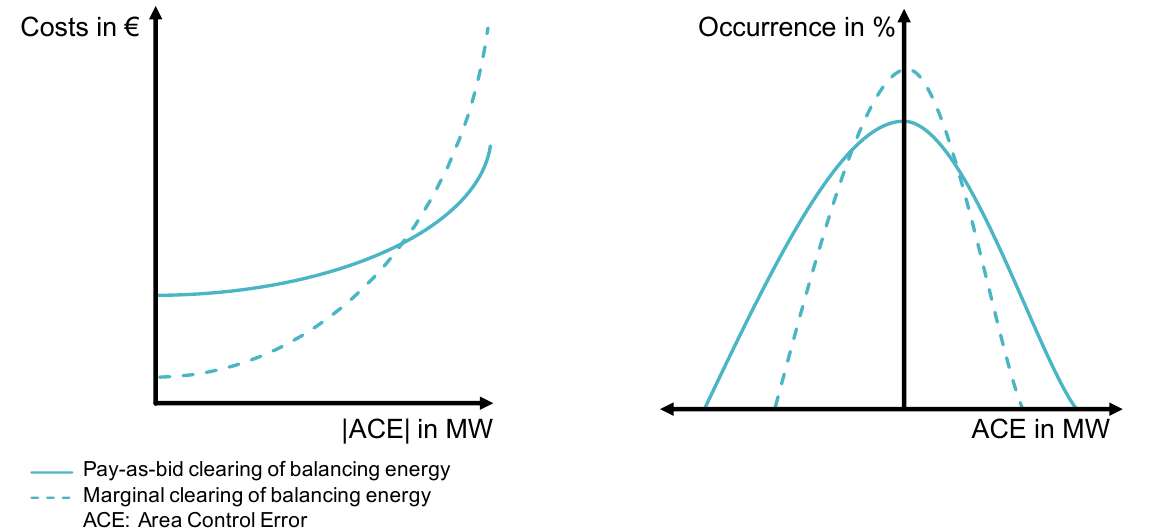
Figure 3. Correlation of costs and imbalance occurrence with pay-as-bid vs. marginal clearing of balancing